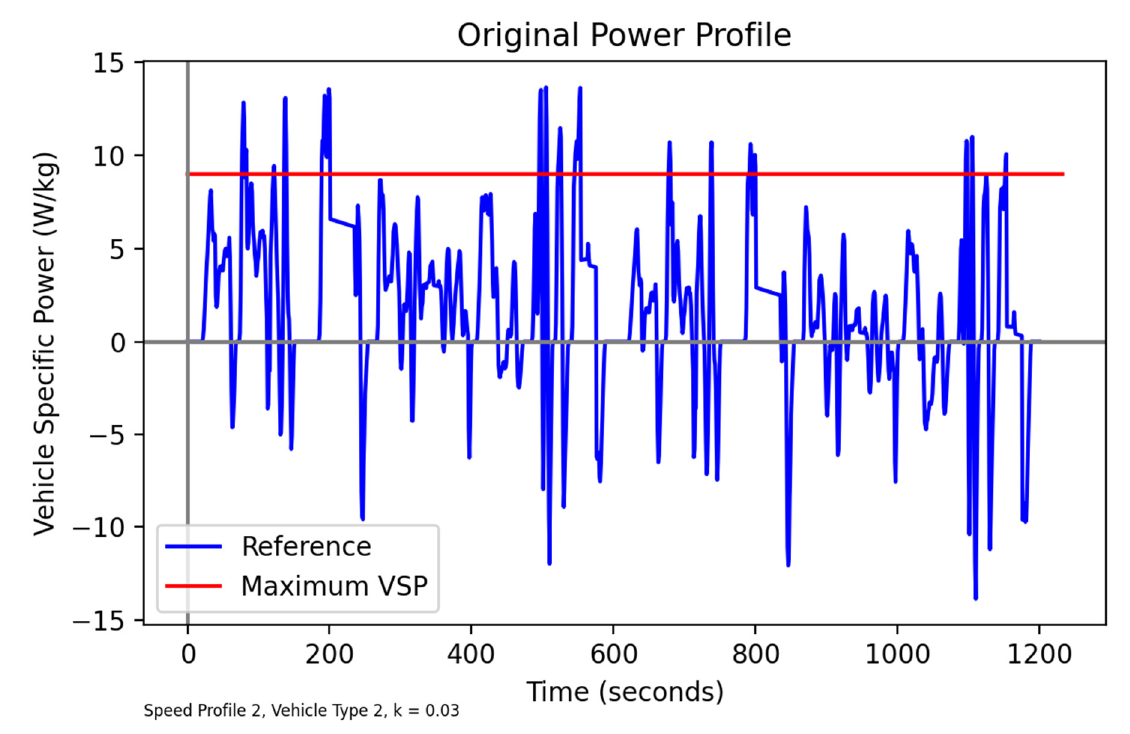
Figure 3. Implied vehicle-specific power for an electric quadricycle following the acceleration profile stipulated in WMTC Reference Cycle 2 (Hilly terrain, k = 0.03).